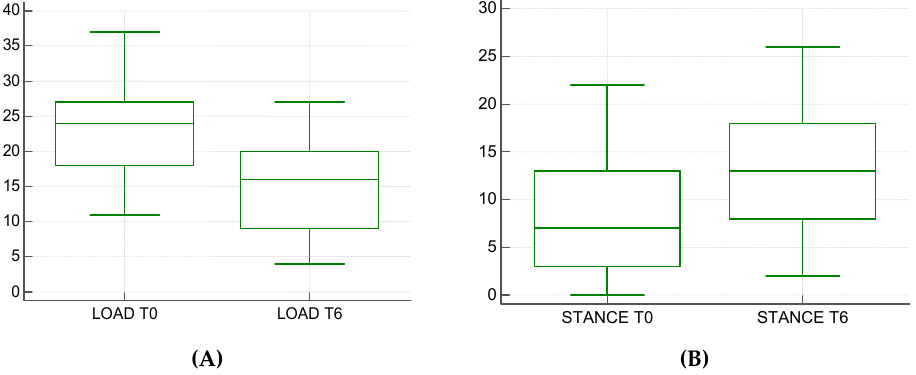
Figure 6. ( A ) A graphic representation of the significant decrease of the LOAD score of dogs from T0 to T6; ( B ) A graphic representation of the significant improvement of the percentage of load bearing on the injured limb from T0 to T6.